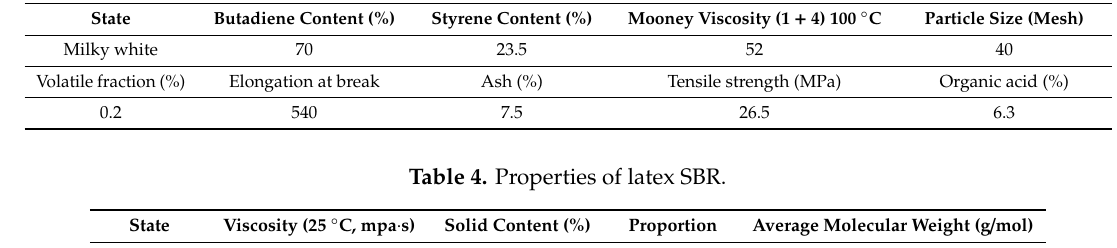
Table 3. Properties of powder Styrene-Butadiene-Rubber (SBR).